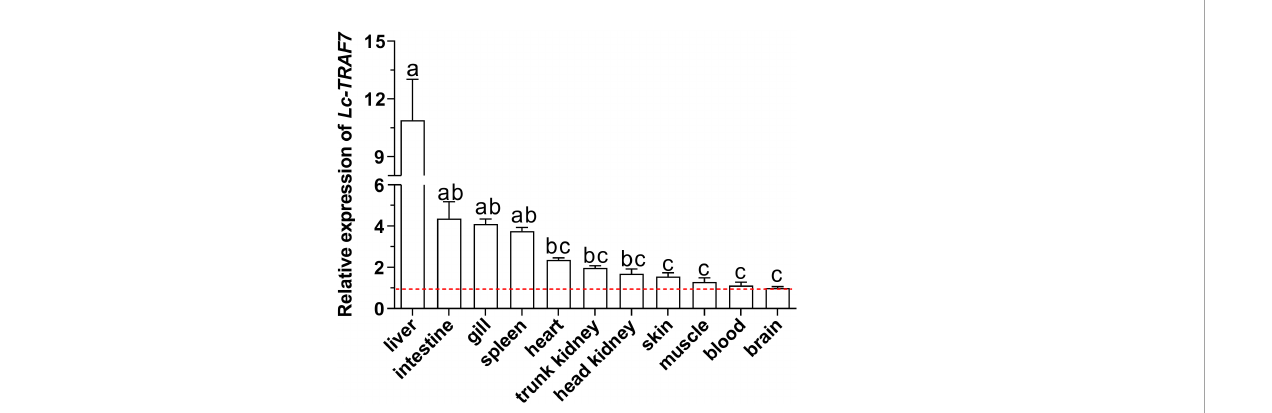
FIGURE 3 Organs/tissues distribution analysis of Lc-TRAF7 mRNA in large yellow croaker. The mRNA expression levels of Lc-TRAF7 were detected in eleven various organs/ tissues of the healthy fi sh by qRT-PCR, with normalizing to the expression of L. crocea b -actin . The mRNA expression level of Lc-TRAF7 in the brain was set as 1- fold, and the mRNA expression levels of Lc-TRAF7 in other organs/tissues were recorded as multiples of the expression level in the brain, and the baseline of 1- fold was marked with the red dotted line. All data were expressed as mean of three repeated experiments, with the bars representing the SE (N = 6). Different superscripts indicate statistical differences between the groups ( P < 0.05), whereas the same superscript indicates no statistical